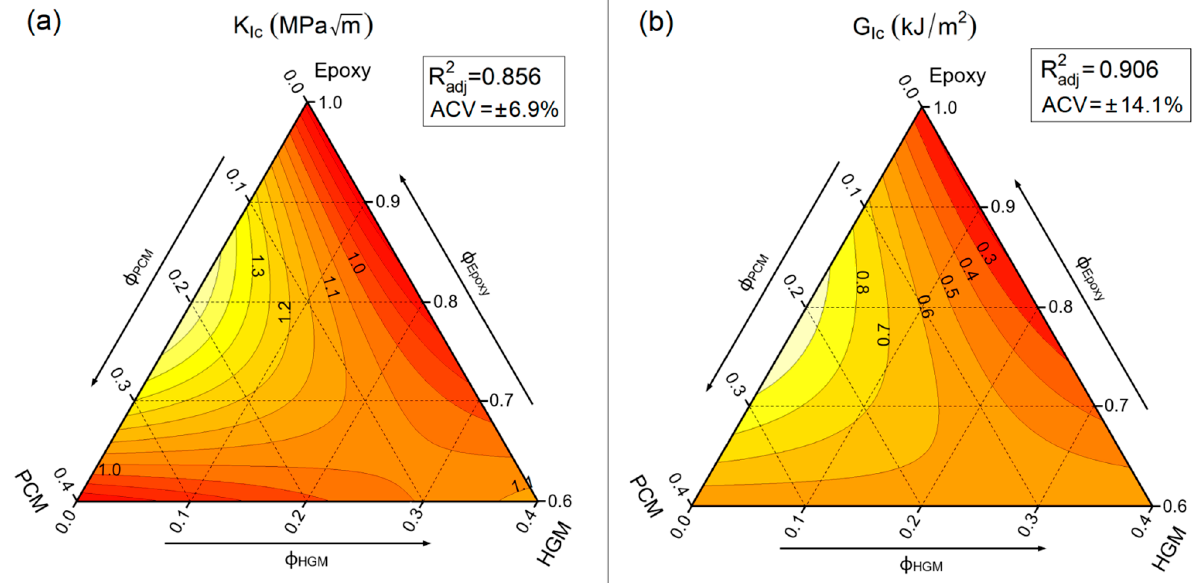
Figure 7. Fit-models of the main results from fracture toughness tests on the prepared syntactic foams. ( a ) mode I fracture toughness (K IC ) and ( b ) critical strain energy release rate (G IC ). R 2adj = adjusted R-squared, ACV = average coefficient of variance.